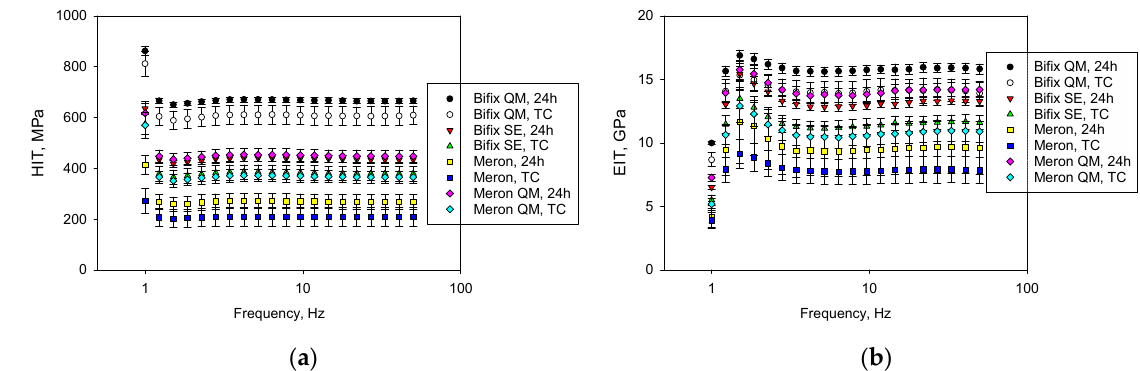
Figure 4. Variation of ( a ) indentation hardness H IT and ( b ) indentation modulus E IT over the frequency range 1–50 Hz for the materials analyzed.